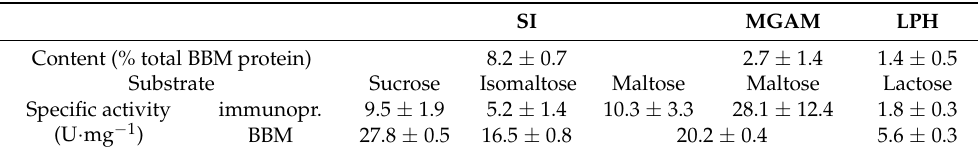
Table 1. The amount and activity of major disaccharidases from human intestinal brush border membrane